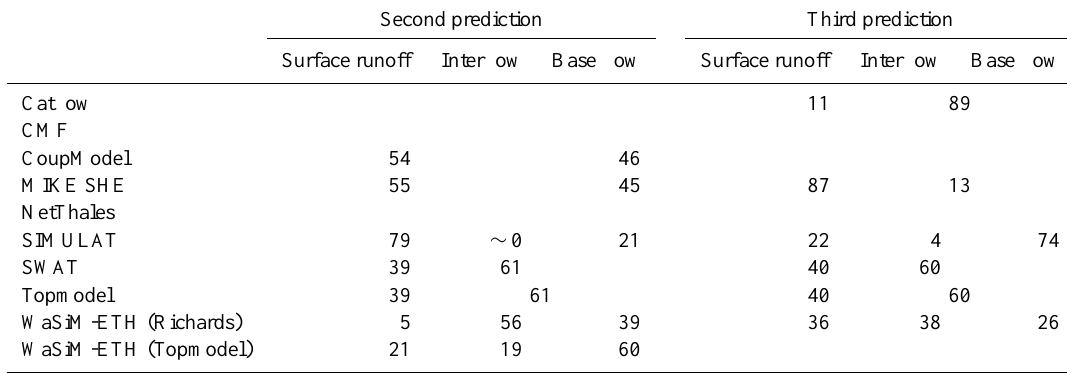
Table 10. Model-specific runoff components of the second year (third prediction) (all numbers in % of total runoff).